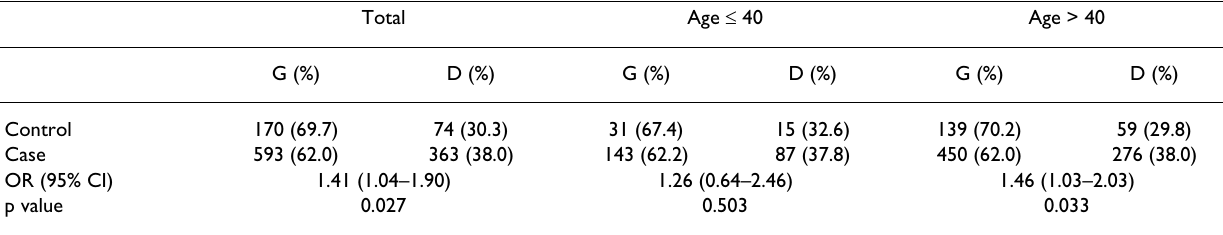
Table 1: Allelic association of DDD with the -1607 polymorphism of